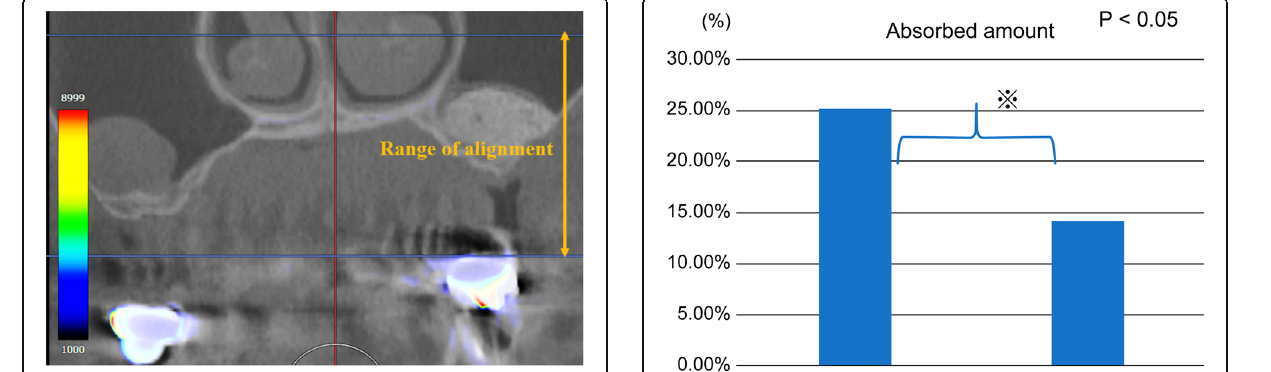
Fig. 3 “ Automatic alignment ” was performed using maxillary arch anatomical landmarks as reference points